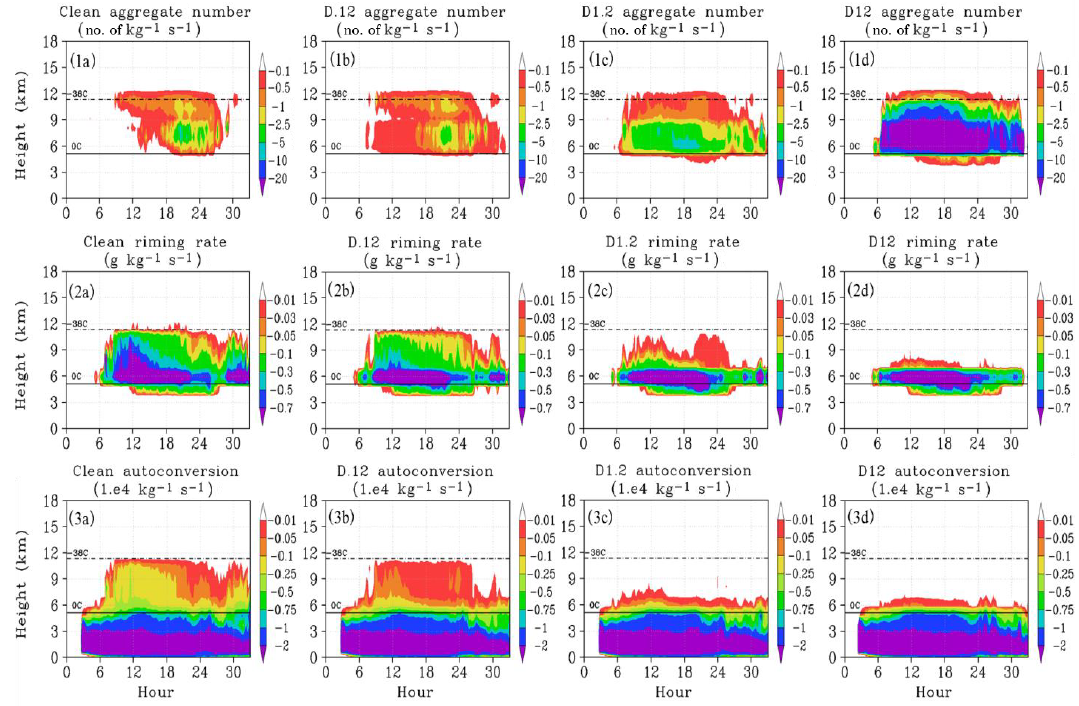
Figure 8. Time series of convective averaged aggregate number (row 1), riming rate (row 2), and drop autoconversion (collision–coalescence) number. Columns: Clean, D.12, D1.2, and D12 cases,